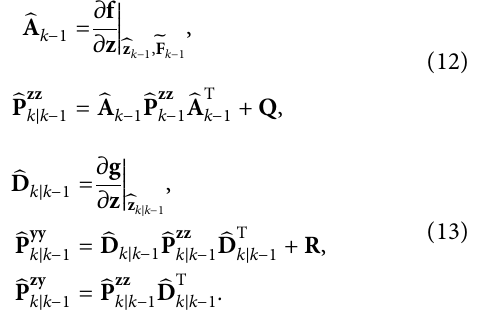
(a–c) and q (b–d), with respect ∗